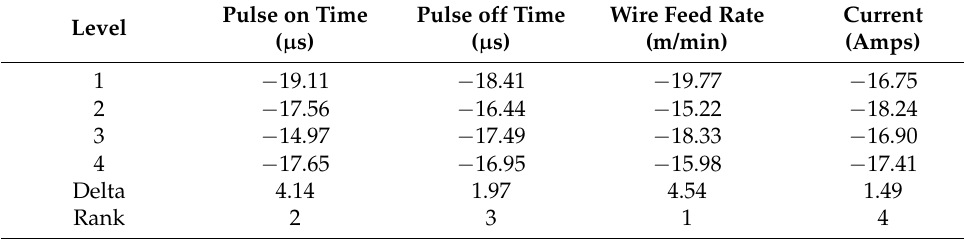
Table 6. Response table for signal to noise ratios (material removal